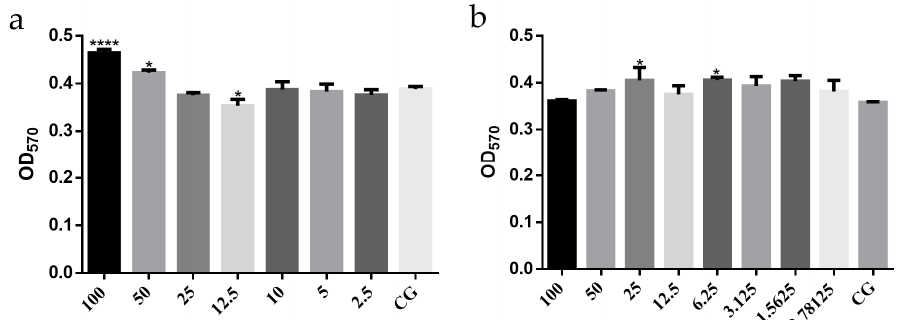
Figure 4. OD 570 values of MTT results for the effect of ATF and LPS on the activity of mouse peritoneal macrophages. ( a ) The effect of ATF on the activity of mouse peritoneal macrophages. ( b )The effect of LPS on the activity of mouse peritoneal macrophages. Data are expressed as mean ± SD. * p < 0.05, **** p < 0.0001 compared with the CG group.